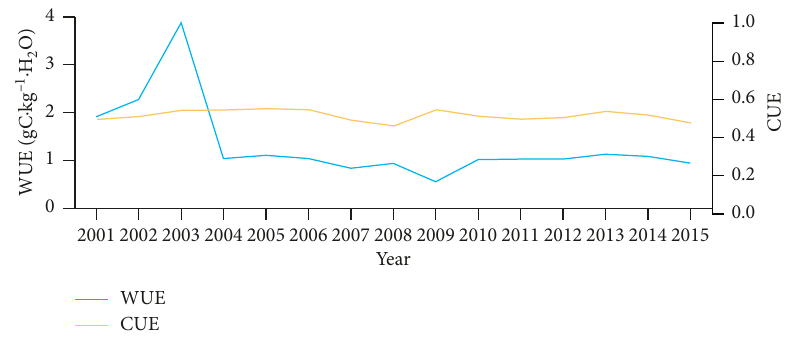
Figure 2: Annual average WUE and CUE in the SNP for the period of